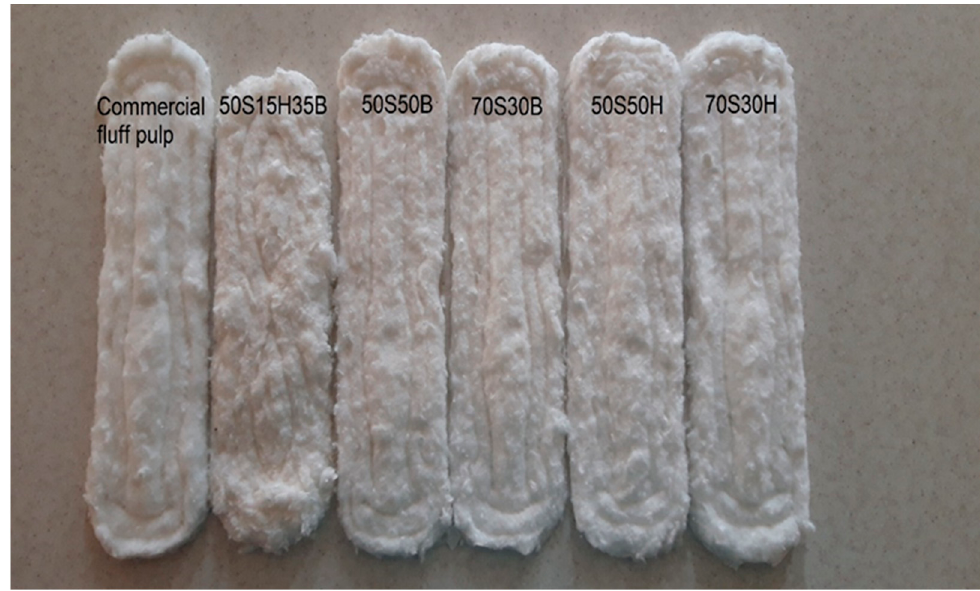
Figure 9. Defibrating types of fluff pulp in the sanitary napkins.